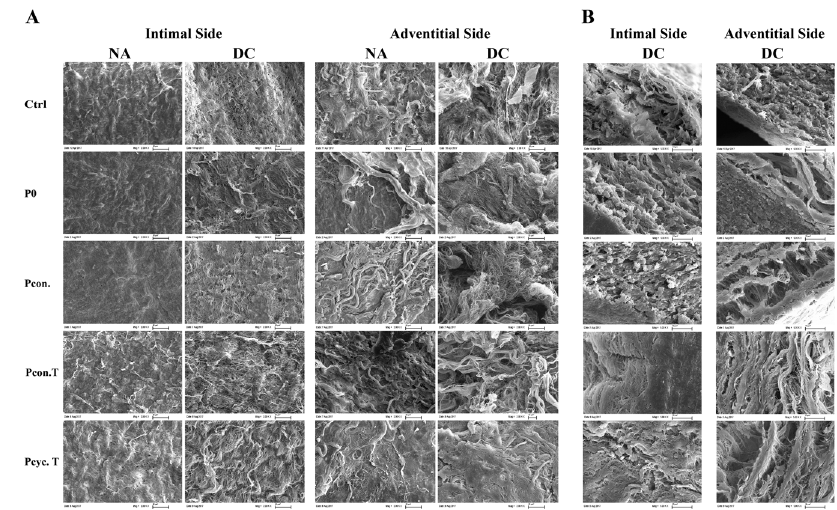
Fig. 5 Scanning electron microscopic images of native as well as decellularized aortic tissue. A Shows images of the intimal as well as adventitial side of the aortic wall, either as native or decellularized tissue. Images were taken at a magni fi cation of ×2.000 (scale bar is 20 µm). In ( B ) the lateral view on native or decellularized aortic tissue is depicted to show the aortic cross-section (intimal as well as adventitial side). Scanning electron microscopic images also show decellularization with no change in aortic structure. Images were taken at a magni fi cation of ×5.000 (scale bar is 10 µm). NA native tissue,